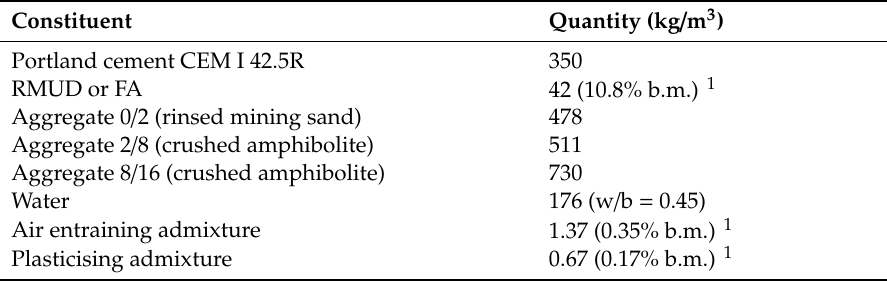
Table 3. Composition of tested concretes.